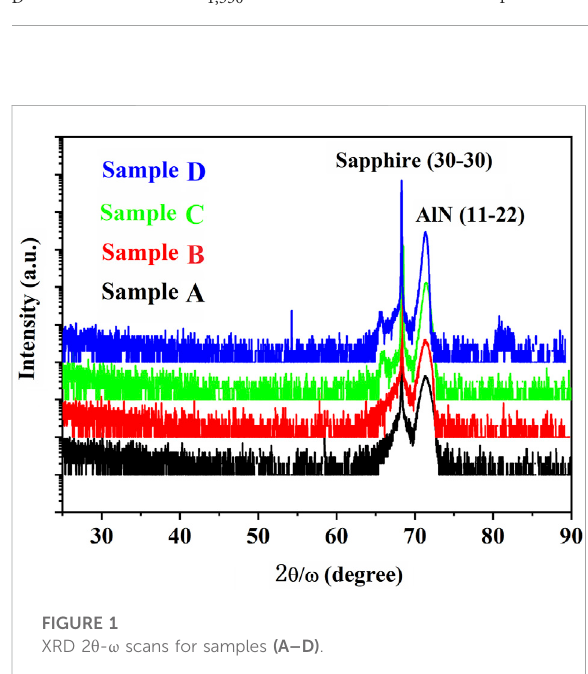
FIGURE 1 XRD 2 θ - ω scans for samples (A – D)